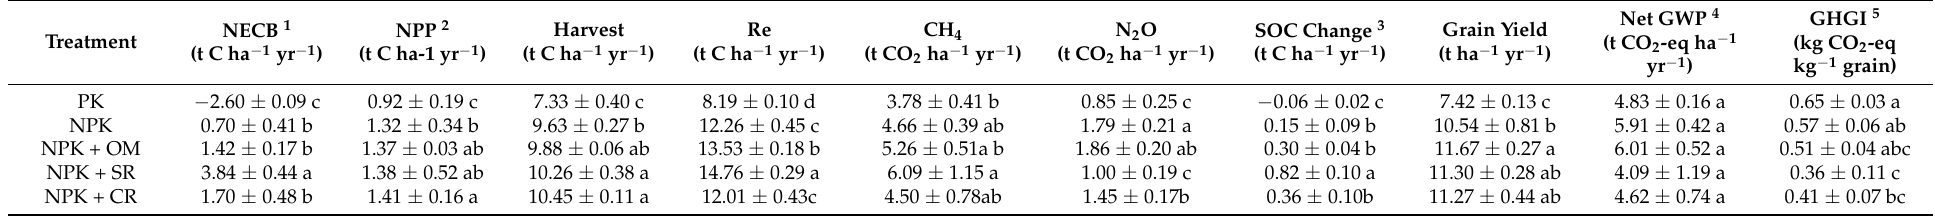
Table 3. NECB and its components (NPP, Harvest and Re), CH 4 and N 2 O emissions, SOC change and Grain yield, net GWP and GHGI over rice-wheat rotation.